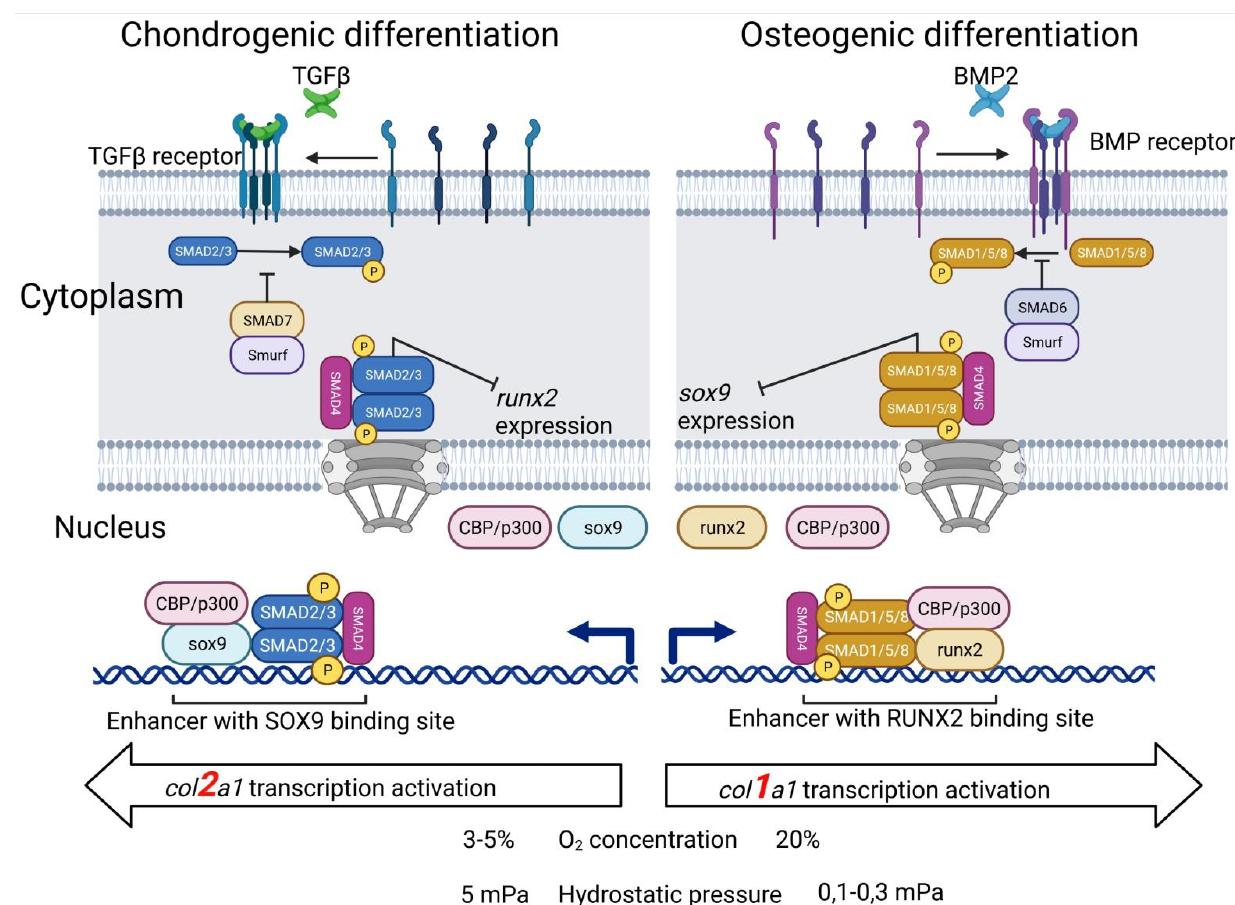
Figure 2. Chondrogenic and osteogenic differentiation of MSCs depends on various conditions and stimuli.